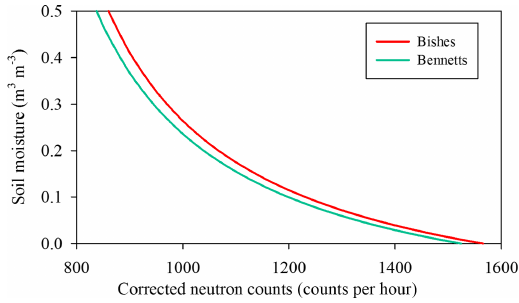
Figure 4. Calibration curves for converting corrected neutron counts to soil moisture content for the Bishes and Bennetts cosmic- ray soil moisture sensors. The dry soil counting rate, N 0 , is 1583 counts per hour for Bishes and 1541 counts per hour for Ben-